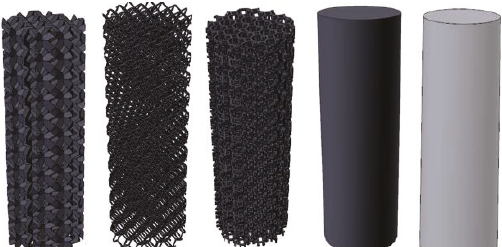
Figure 2. The 3D printing design of animal experiment implant specimen: From the left—Additive Manufacturing Type 1, Additive Manufacturing Type 2, Additive Manufacturing type 3, Additive Manufacturing Solid and Machined Solid.